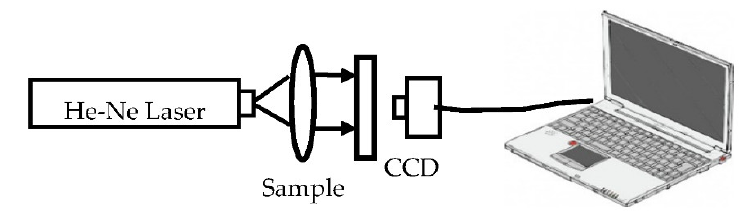
Figure 12. Experimental setup.